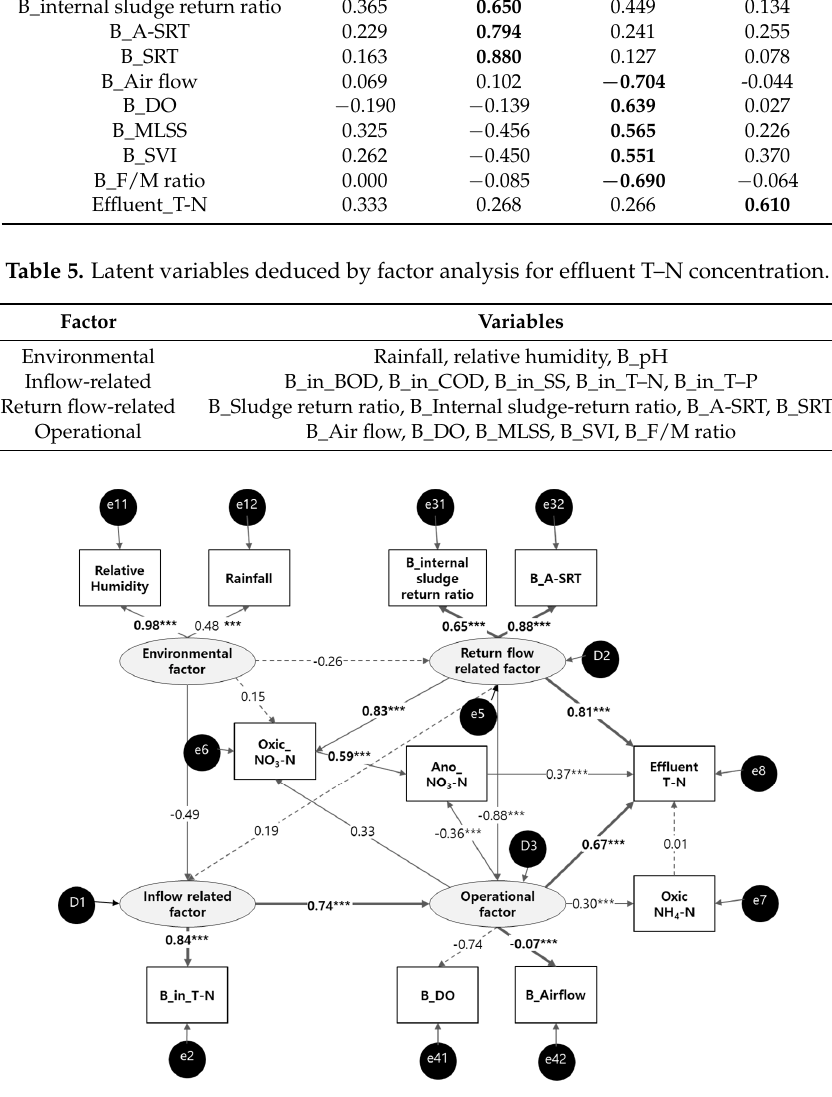
Figure 4. Structural equation model for effluent T–N